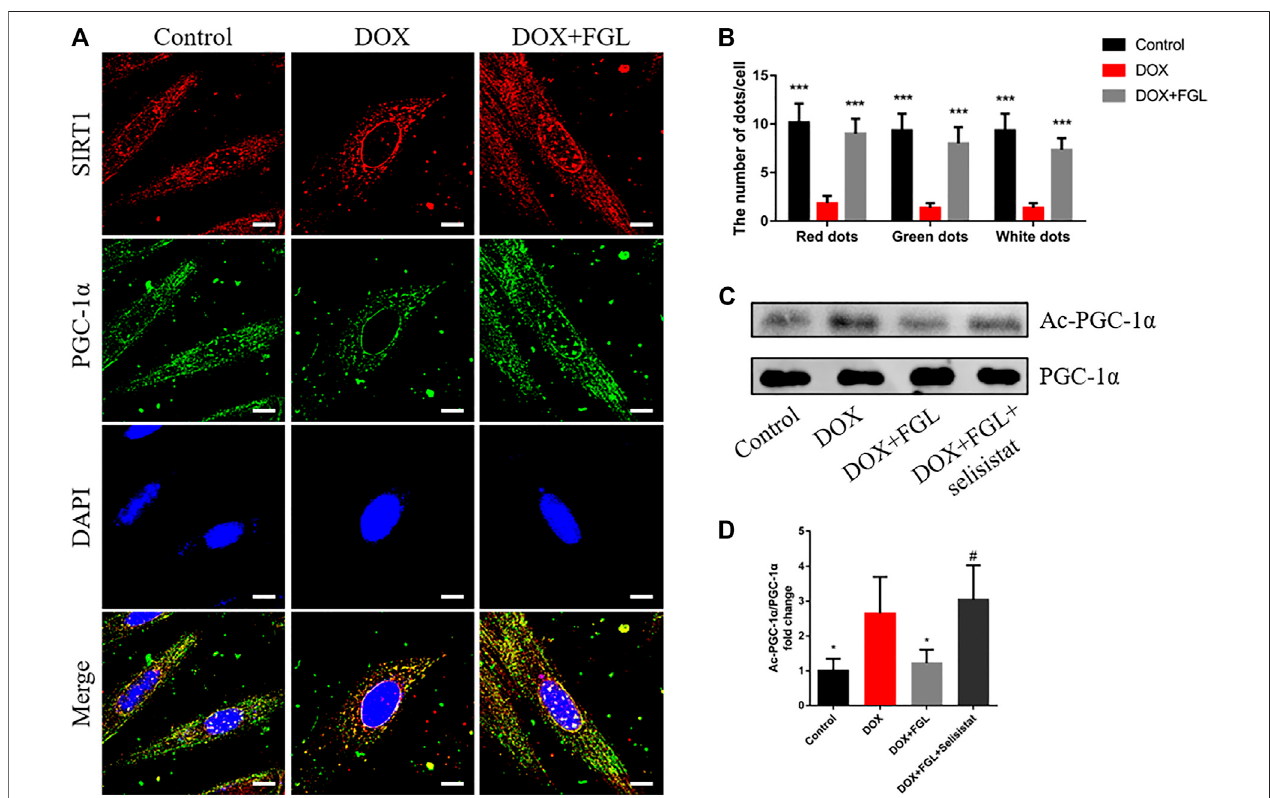
FIGURE 6 | FGL promoted the deacetylation of SIRT1 to PGC-1 α in vitro . (A, B) Representative images and quantitative analysis of SIRT1 and PGC-1 α and their colocalization in the nucleus (n (cid:2) 6). Scale bar: 10 μ m. (C, D) Representative bands and the ratio of acetylated PGC-1 α to total PGC-1 α detected by CO-IP of PGC-1 α and acetylated lysine (n (cid:2) 4). * p < 0.05, ** p < 0.01, *** p < 0.001 vs DOX group. # p < 0.05 vs. (DOX + FGL)